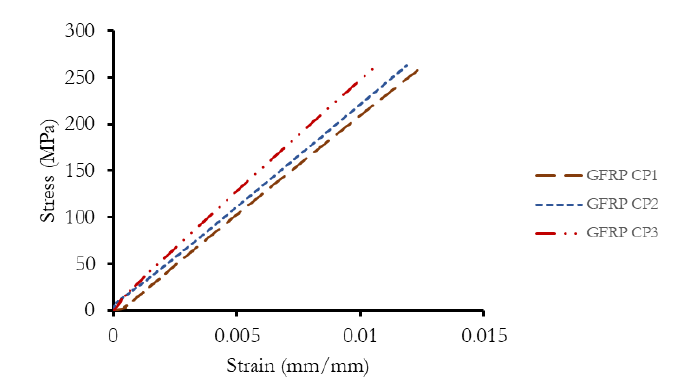
Figure 6. Stress versus strain graph obtained by the uniaxial tensile test on 3 GFRP specimens.